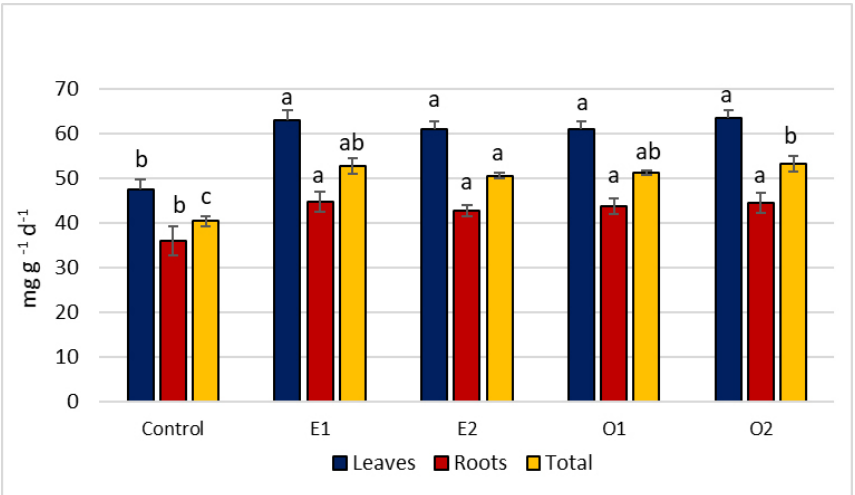
Figure 2. Dynamic of the RGR in plant parts of Tanacetum balsamita . Error bars represent the standard deviation (SD). Different letters above each column indicate significant differences among the treatments (Tukey’s test p <